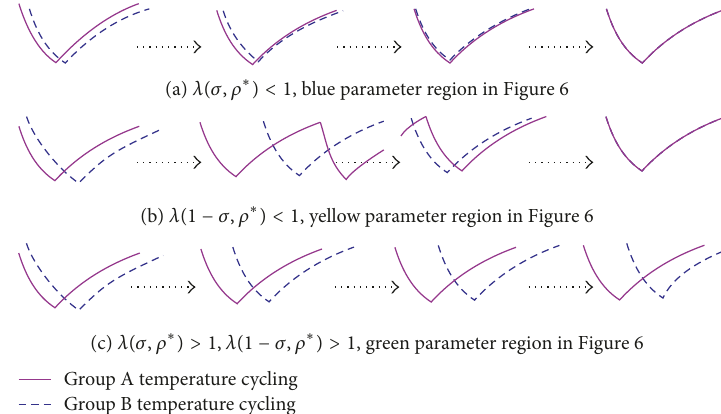
Figure 7: Illustration of the three types of cycling behaviour of two groups relative to one another, based on simulations. Arrows indicate the occurrence of many cycles and the central illustrations are snapshots of the cycling behaviour between the start and the final behaviour. Synchronisation occurs in cases (a) and (b), while in case (c) each group tends towards a fixed phase difference apart.